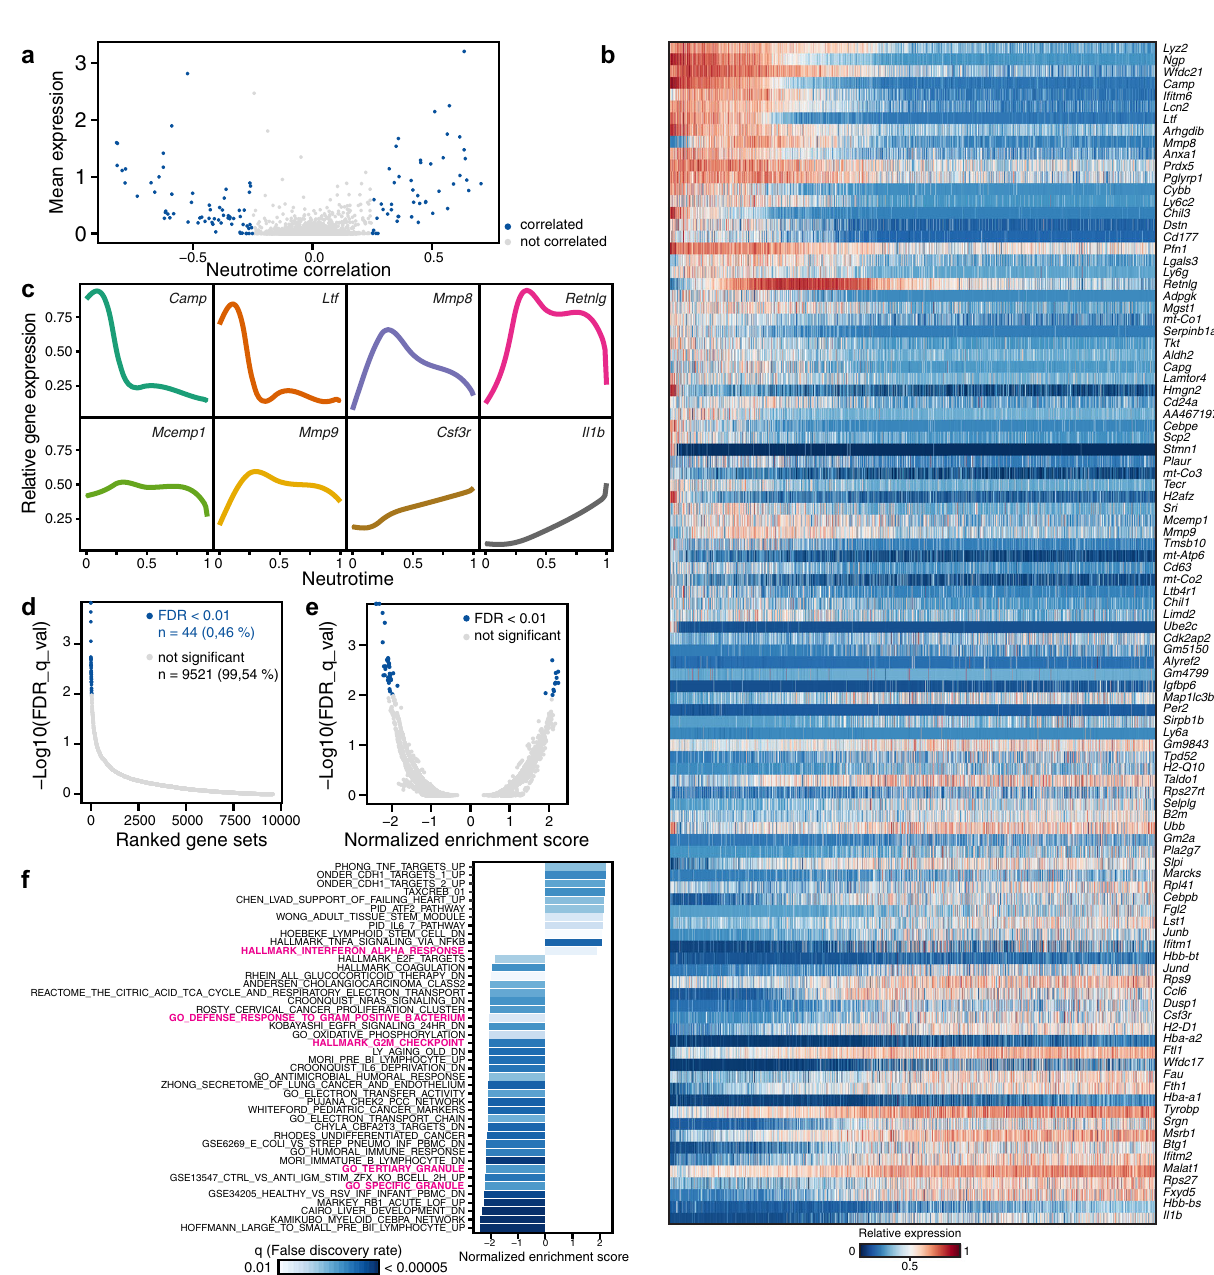
Fig. 3 Gene expression along neutrotime. a Gene expression correlation with neutrotime. Genes with Spearman correlation ≥ 0.25 ( N = 48) and ≤ − 0.25 ( N = 66) are highlighted. b Gene expression heatmap of the top 50 positively and negatively correlated (Spearman) genes along neutrotime. c Gene expression pro fi les of select genes along neutrotime. d Ranked gene sets from Gene Set Enrichment Analysis (GSEA) versus false discovery rate. e Normalized enrichment score of GSEA gene sets versus false discovery rate. f Signi fi cantly enriched gene sets. Neutrophil-speci fi c terms are highlighted in magenta. GSEA was performed as previously described. 76 In short, a normalized enrichment score was calculated by going through a list of genes based on their Spearman correlation with neutrotime as a pre-ranked list and calculating a running-sum statistic, which was then normalized for differences in the sizes of the gene sets that were looked at (normalized enrichment score). To account for multiple hypothesis testing, an FDR approach was used to maintain a de fi ned level of signi fi cance, values < 0.01 were